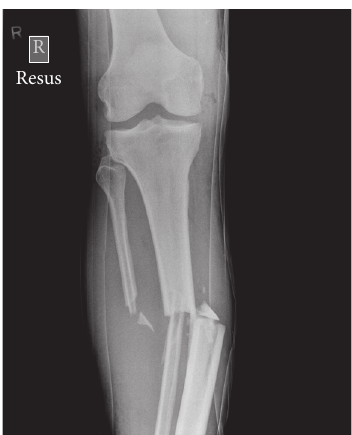
Figure 3: Case two: anteroposterior view of the tibial shaft suggest- ing a tibiofibula